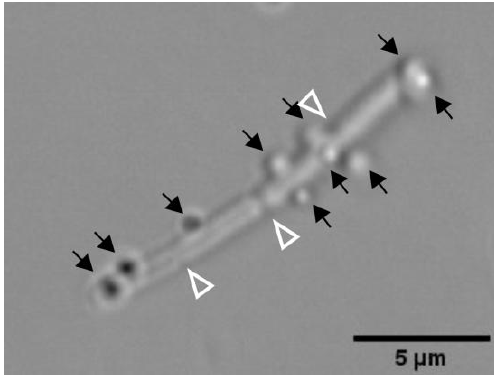
Figure 4. Silica particles attached to two chained B. subtilis cells that are already starting to divide again. The bacteria-particle suspensions were incubated at 37 °C (550 rpm) for at least 30 min to promote bacteria-particle interactions prior to the microscopic observation. The abiotic particles are indicated with full black head arrows. Bacterial septa are indicated with empty white head arrows. Phase contrast image of strain TMB3909. Scale bar is 5 µm.